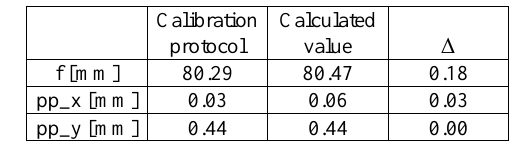
Table 2. Results of camera calibration for 80 mm lens.